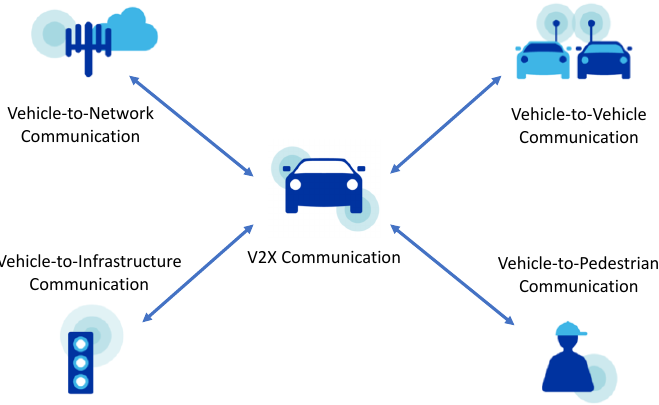
Figure 1. Towards seamless, ubiquitous vehicle-to-everything (V2X)